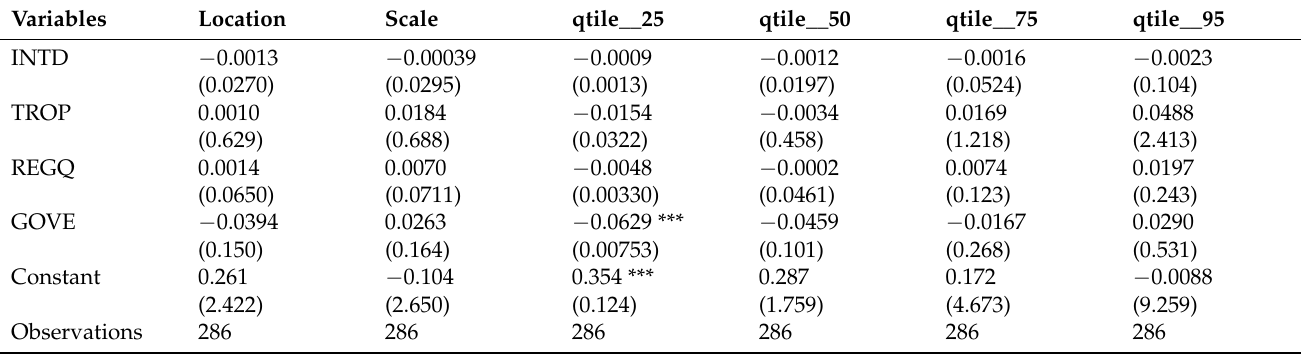
Table 8. Model 6. DV: Income Share of the Top 1% (IN1).